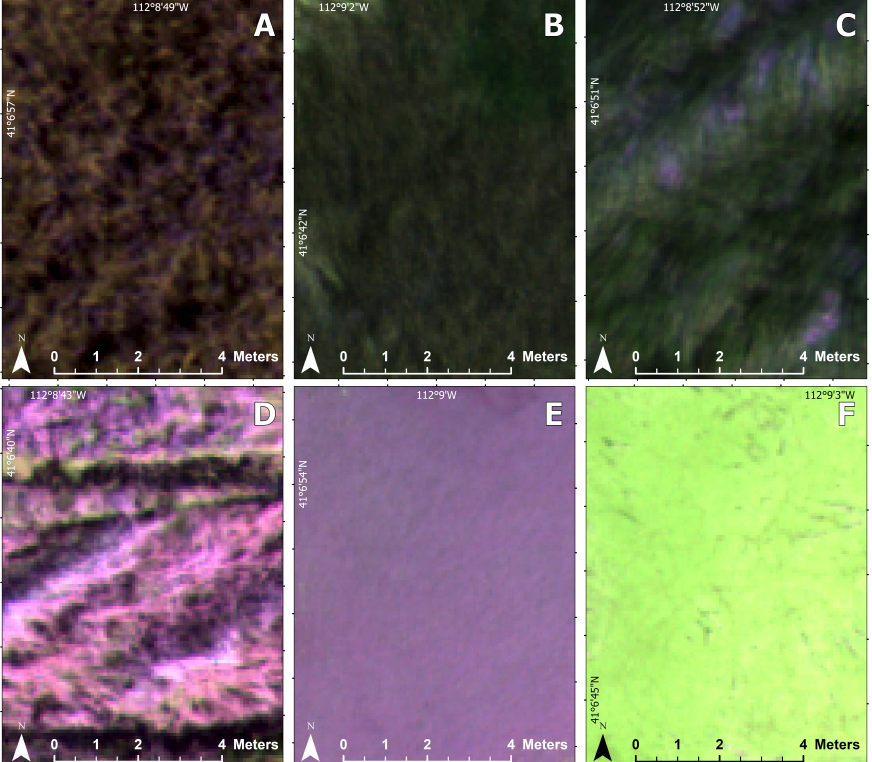
Figure 3. Examples of each land cover class from the orthomosaic. Each tile has been contrast stretched to highlight differences in texture: ( A ) Phragmites ; ( B ) cattail; ( C ) bulrush; ( D ) non- photosynthetic; ( E ) water; ( F ) algae.